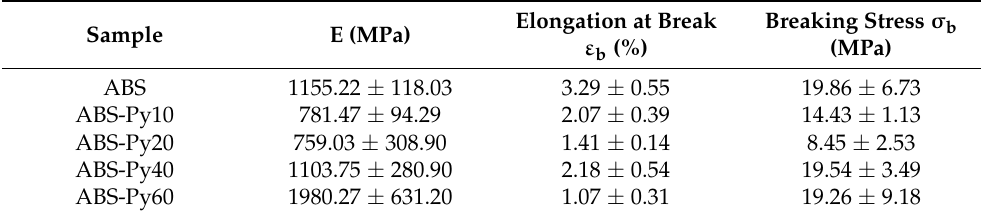
Figure 7. ( a ) Stress–strain curves for representative neat ABS polymer and representative Py-based composites. ( b ) Evolution of the Young’s modulus of the materials as a function of filler concentration. Table 3. Summary of the average mechanical characteristics of the ABS and the composites with different content of